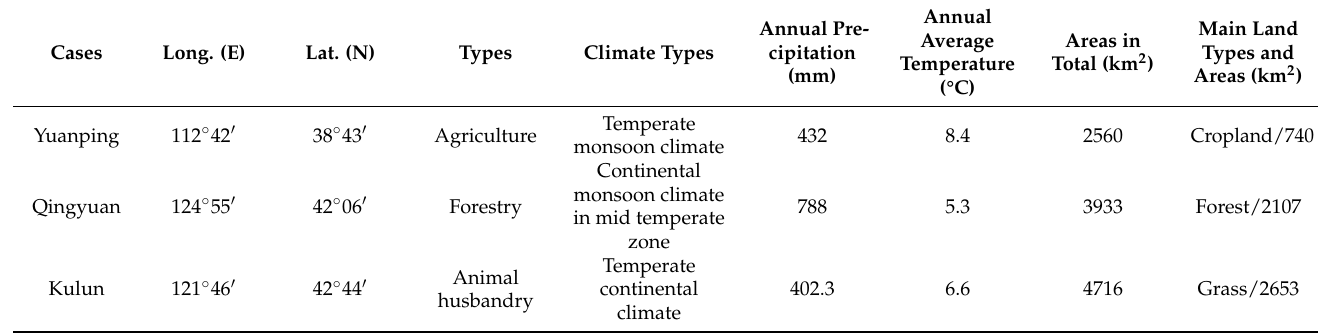
Figure 1. Location of the study area ( a ), land use of Qingyuan ( b ), Yuanping ( c ), and Kulun ( d ). Table 1. Natural conditions and climate profiles of study